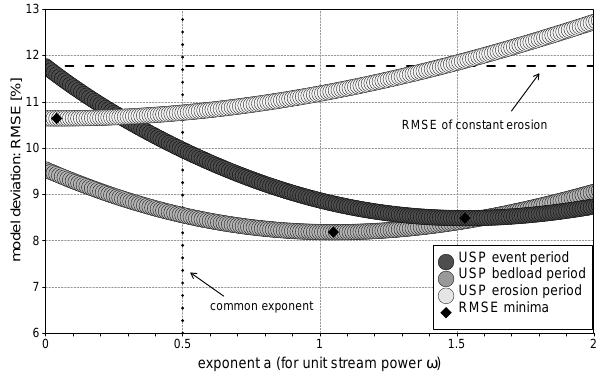
Figure 4. Performance of the USP model expressed as RMSE de- viation from measured erosion c3i for the common range of the unit stream power exponent a (increments of 0.1) for the three time peri- ods. The dotted vertical line indicates the commonly used exponent of 0.5; the diamonds show optimized parameters and the dashed line is the RMSE value of constant erosion (model HO) for the event pe-